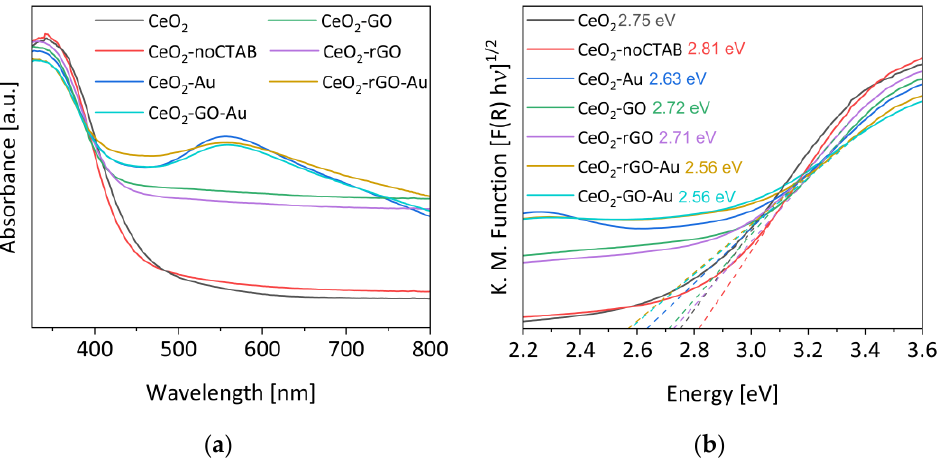
Figure 4. ( a ) UV-DRS of the samples and ( b ) their TAUC plots with the corresponding linear fitting (dashed lines) for the estimation of the band gap.